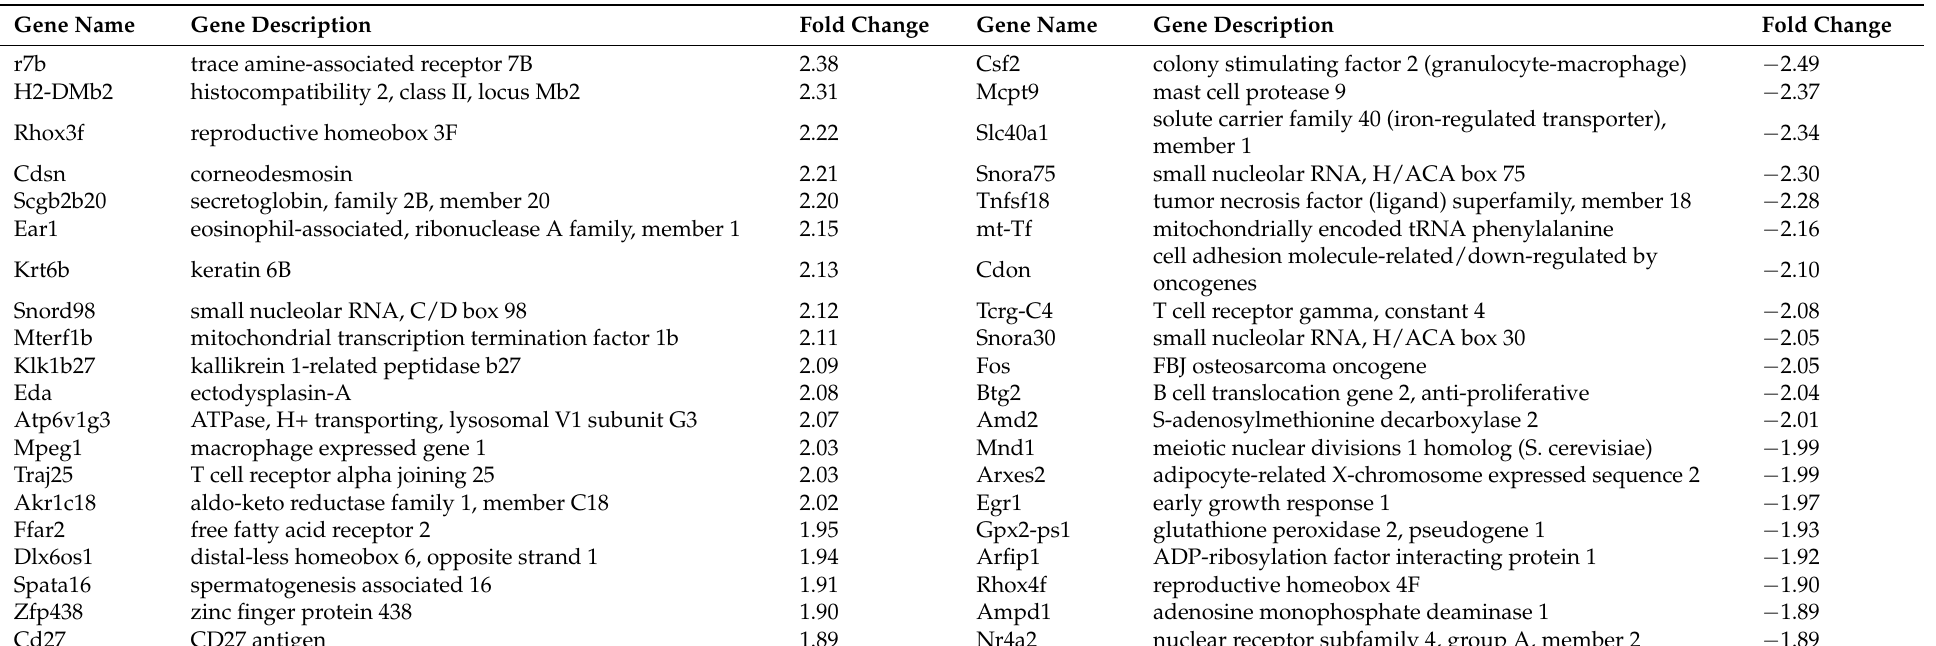
Table 6. List of top 20 up and downregulated genes in 48 h metformin-pretreated